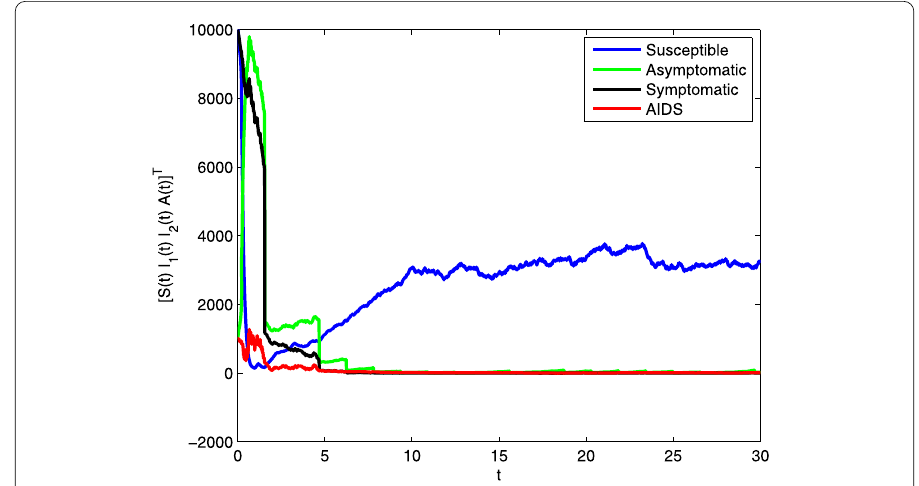
Figure 5 Simulations of system (32) with pulse vaccination parameter ν = 0.8